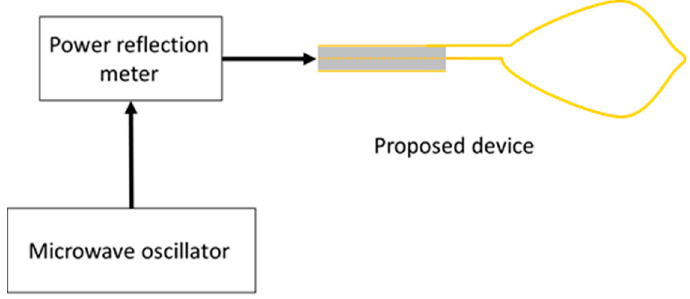
Figure 10. Prototype device.